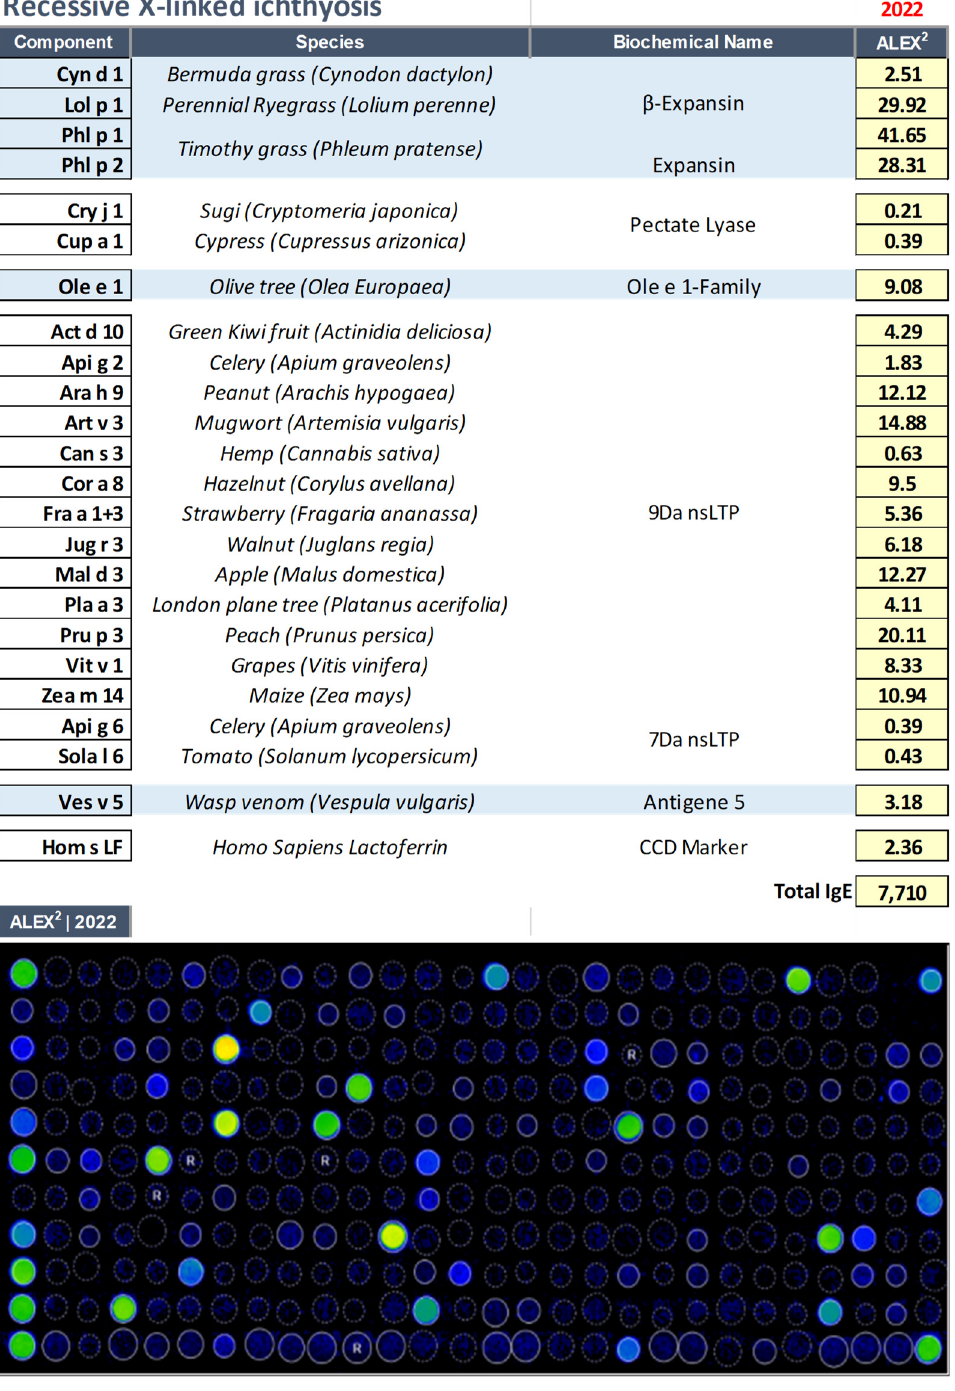
Figure 1. IgE sensitization profile as evaluated through multiplexed proteomic evaluations with Allergy Explorer–ALEX2®2 macroarray in the patient affected by recessive X–linked ichthyosis Allergy Explorer–ALEX2 ® 2 macroarray in the patient affected by recessive X–linked ichthyosis (RXLI, OMIM: 308100) . (RXLI, OMIM: